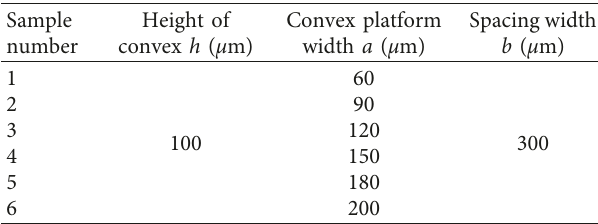
Figure 5: Schematic diagram of machining for the micromilling Table 1: Processing parameters of the grating structure.